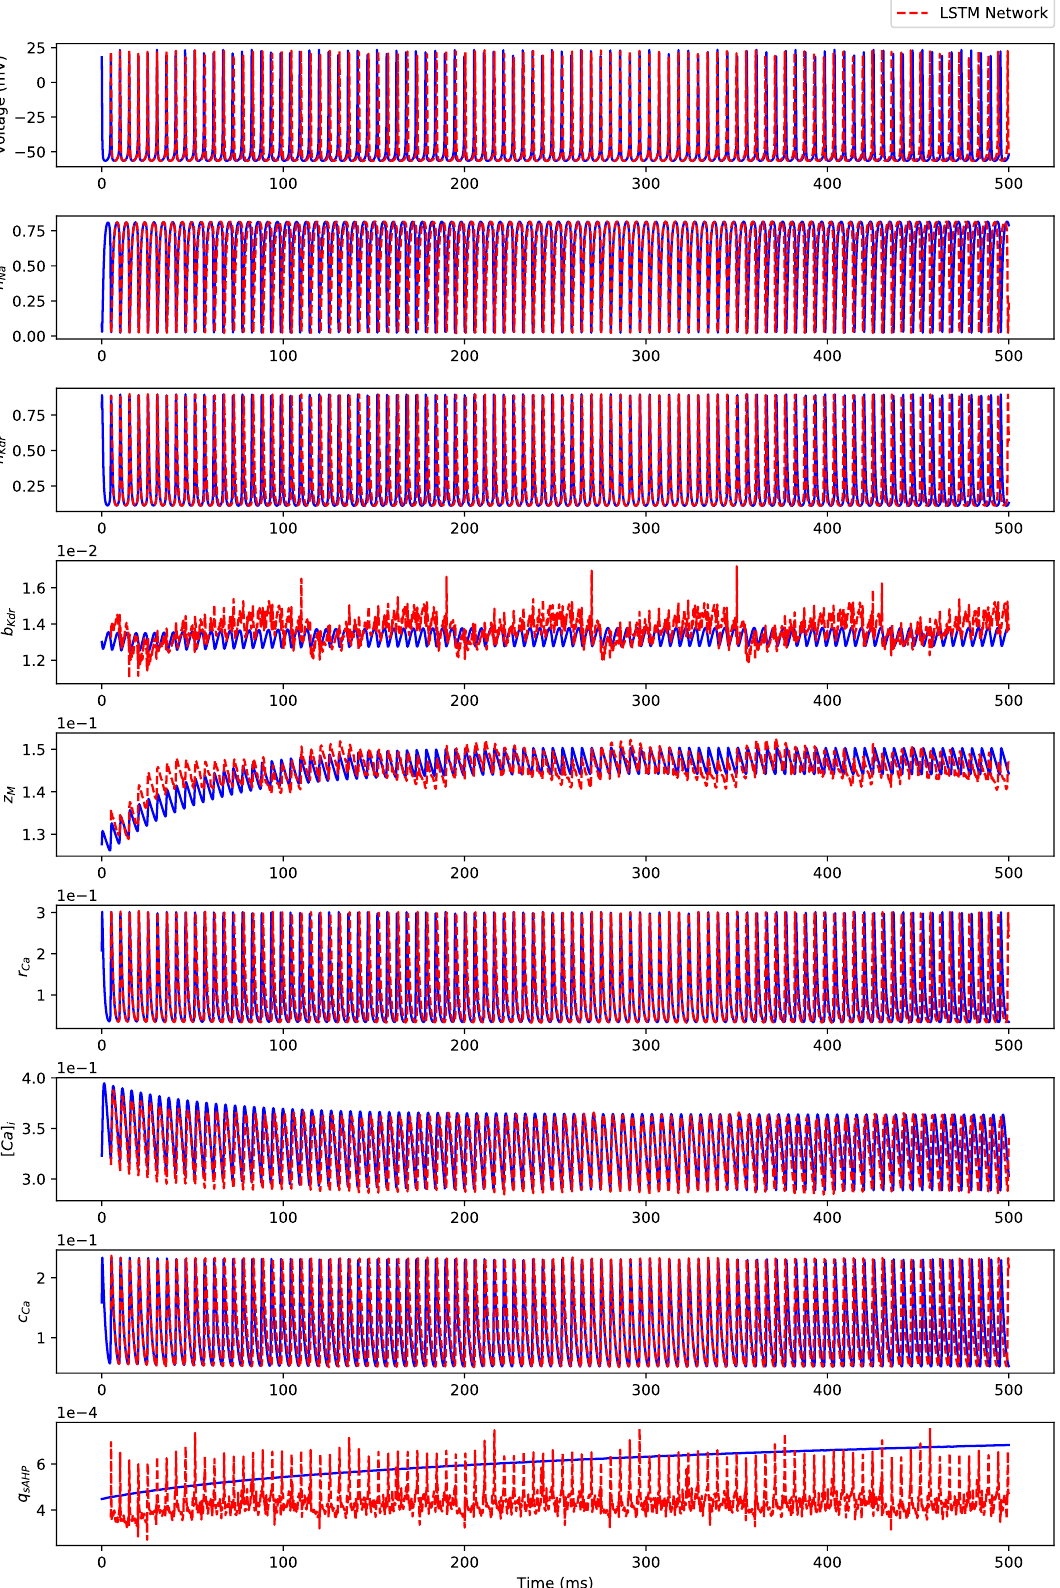
Figure A2. Comparison between the Hodgkin-Huxley model (“HH Model”) states’ dynamics and the iterative predictions of states’ dynamics using the 50 timesteps predictive horizon-based deep LSTM neural network (“LSTM Network”) in response to I = 3.0